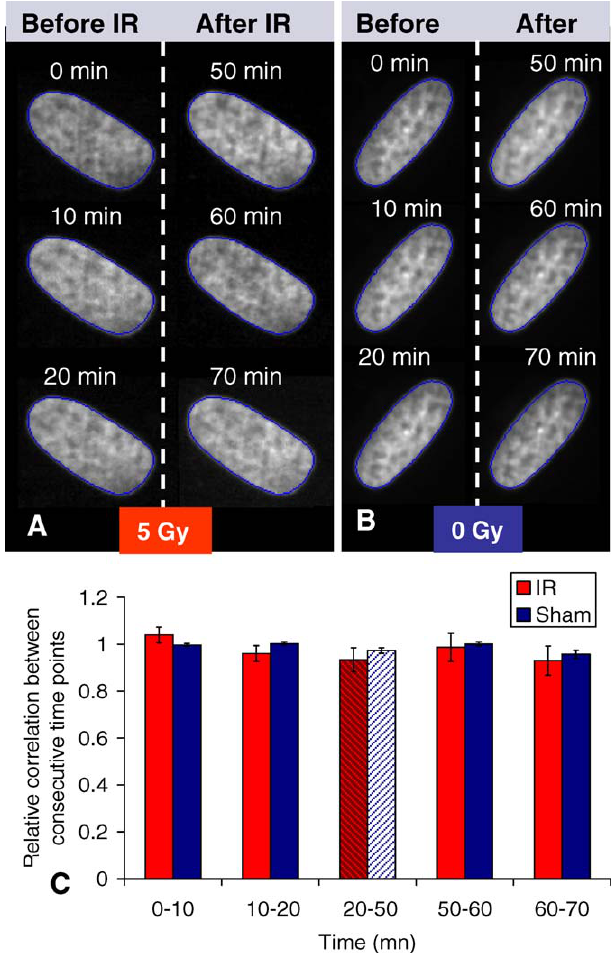
Figure 10. No Decondensation of Chromatin following 5 Gy of Low LET HeLa cells transfected with H1.2-GFP (see Materials and Methods) were imaged before and after exposure to 5 Gy of X-rays (A). Control cells that were not exposed to X-rays were also monitored (B). Intensity correlation within the nucleus (contour shown in blue on images) was computed between consecutive time points. To correct for noise which is unique to each image, correlation values were normalized to the average correlation measured for the three first time points (i.e., before radiation). These relative correlations are graphed in (C) for both groups (i.e., each group represents averages from five different nuclei). Correlation values before and after radiation (20–50 min) are shown on the graph by dashes on the bars for both control and irradiated specimen.